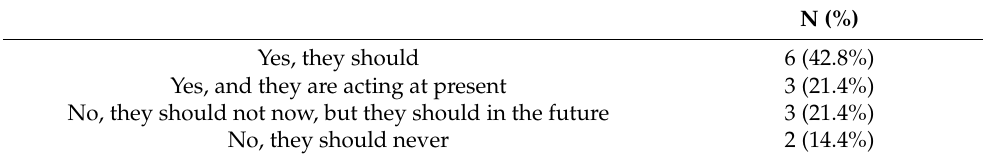
Table 4. Interviewees’ Perceptions: should there be a fight against the impacts of climate change (Q6). N (%) Yes, they should 6